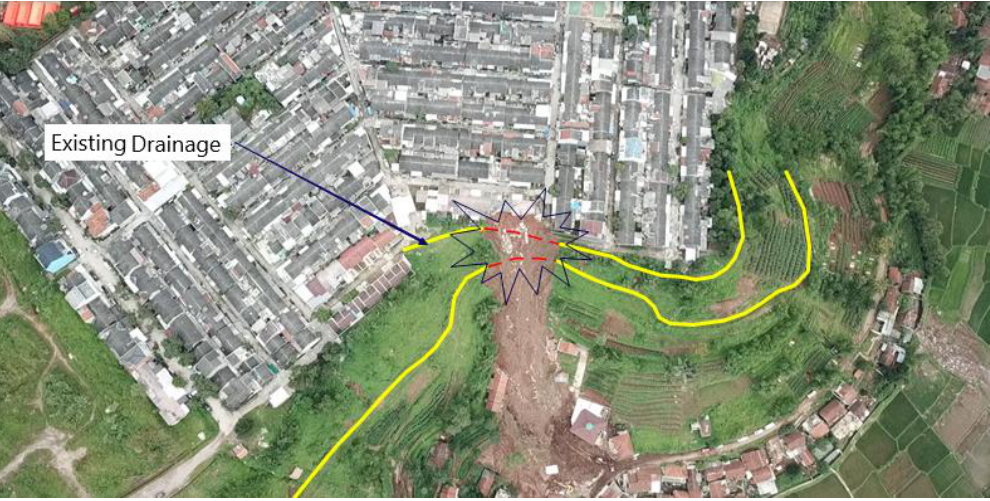
Figure 4. Waterflow and overtopping at the crown of the slope.